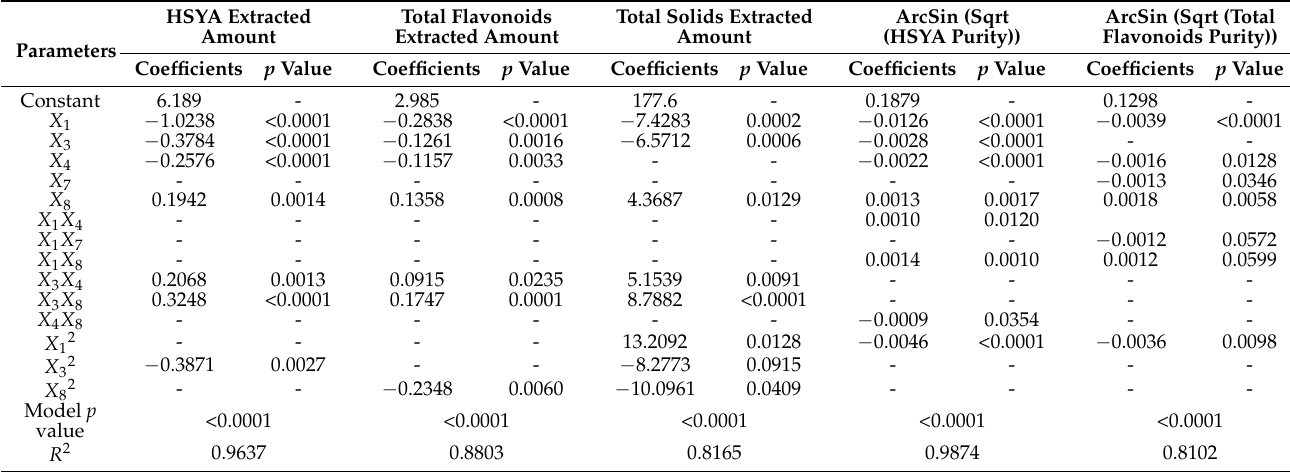
Table A2. Regression coefficients and variance analysis of the quadratic multiple regression